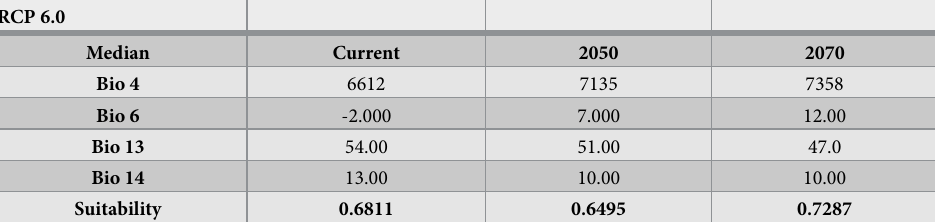
Table 4. Evolution of the medians for the selected bioclimatic variables under the RCP 6.0 scenario. The evolution of the suitability medians is also shown on the bottom row. All the values are taken at the current locations of G